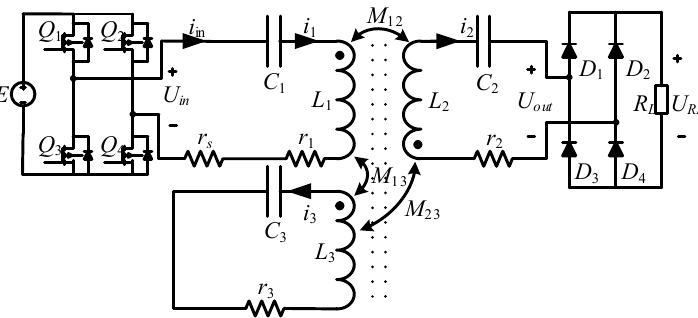
Figure 1. Configuration of the proposed series-series compensated 3-coil IPT (inductive power transfer) system.